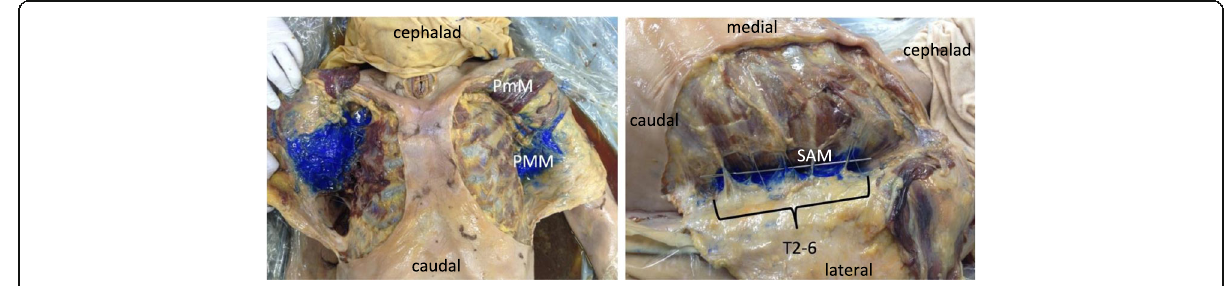
Fig. 2 Dissections after color dye injections